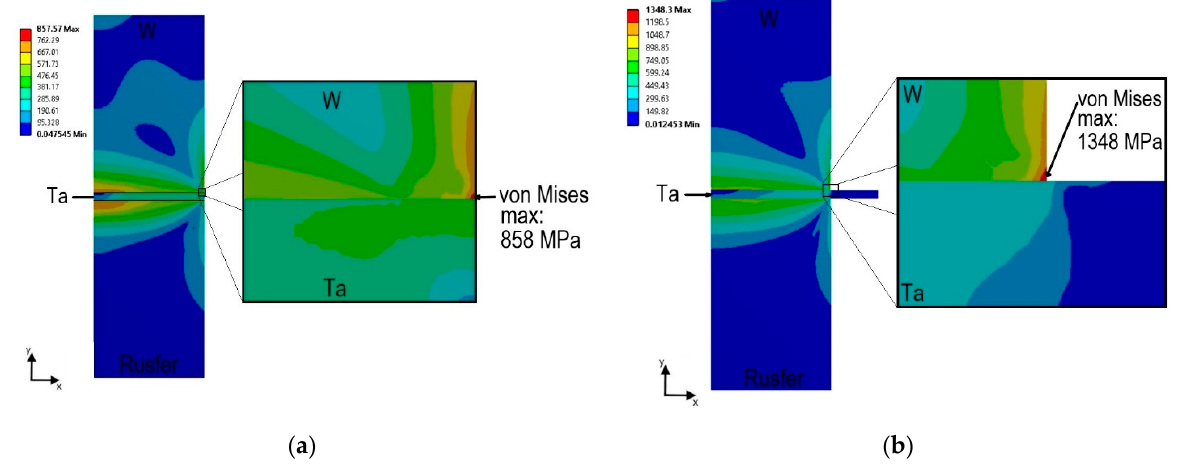
Figure 12. Contour plots of the equivalent von Mises stress distributions after cooling the first ( a ) and second ( b ) assemblies. Only the right halves of the symmetric assemblies are depicted.